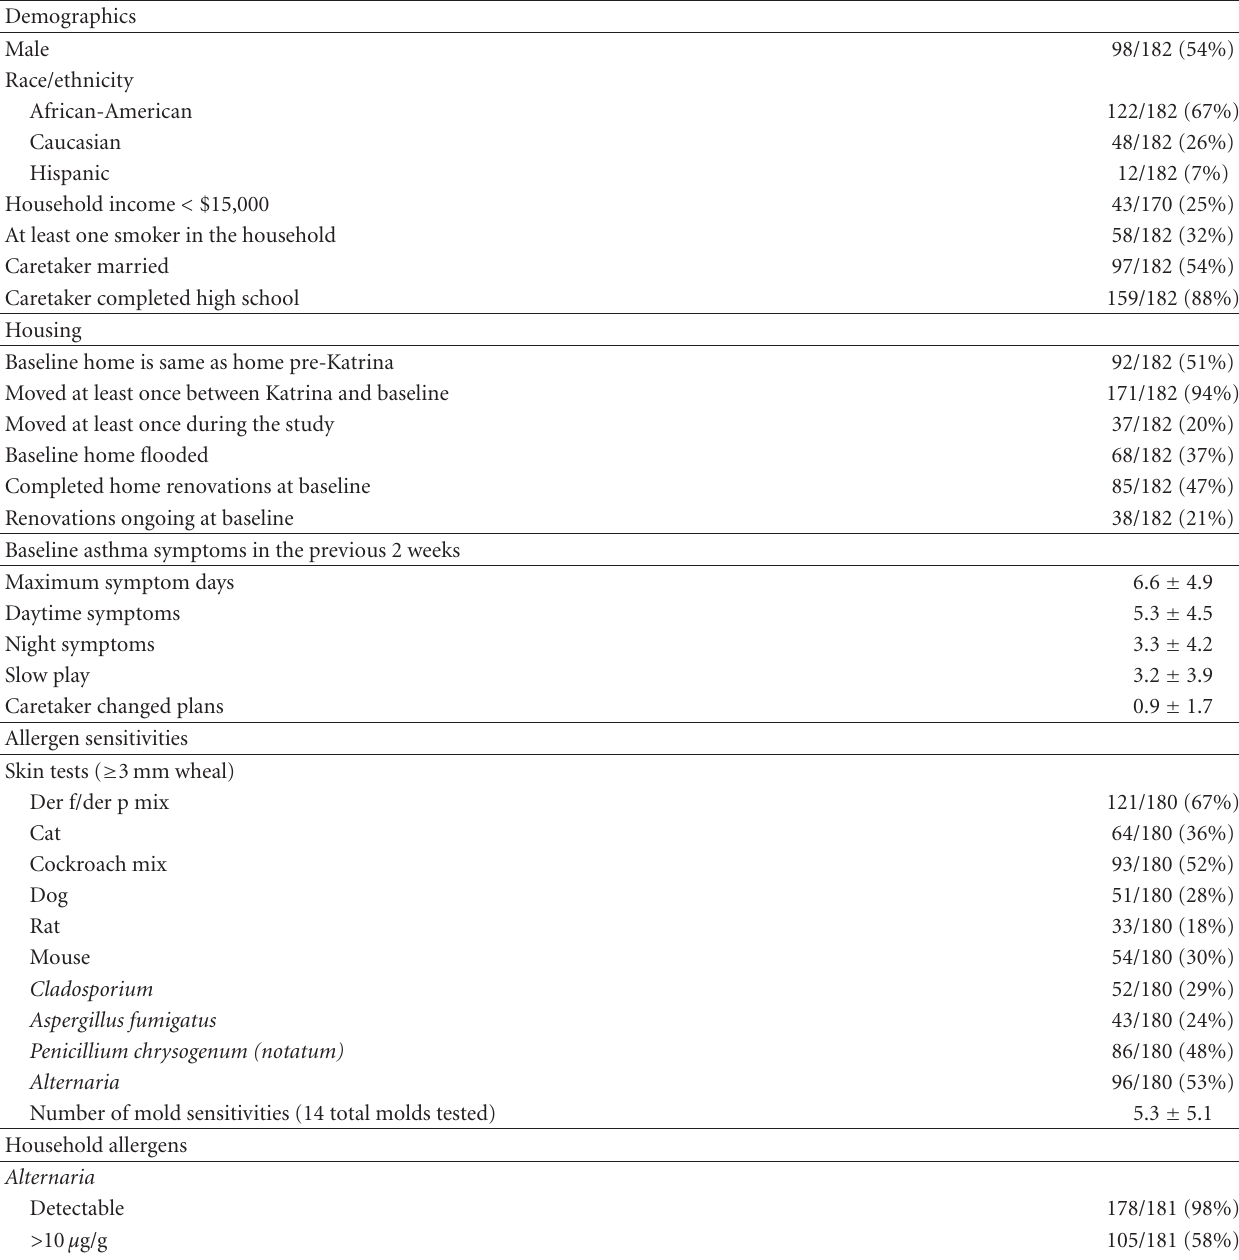
Table 1: Baseline characteristics of the study population ( N =